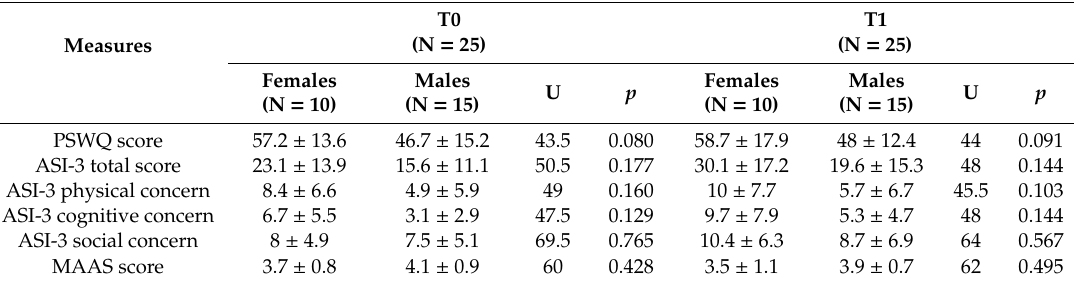
Table 1. Worry, anxiety, and trait mindfulness before (T0) and at the end (T1) of the Italy COVID-19 lockdown, separately in female and male participants.